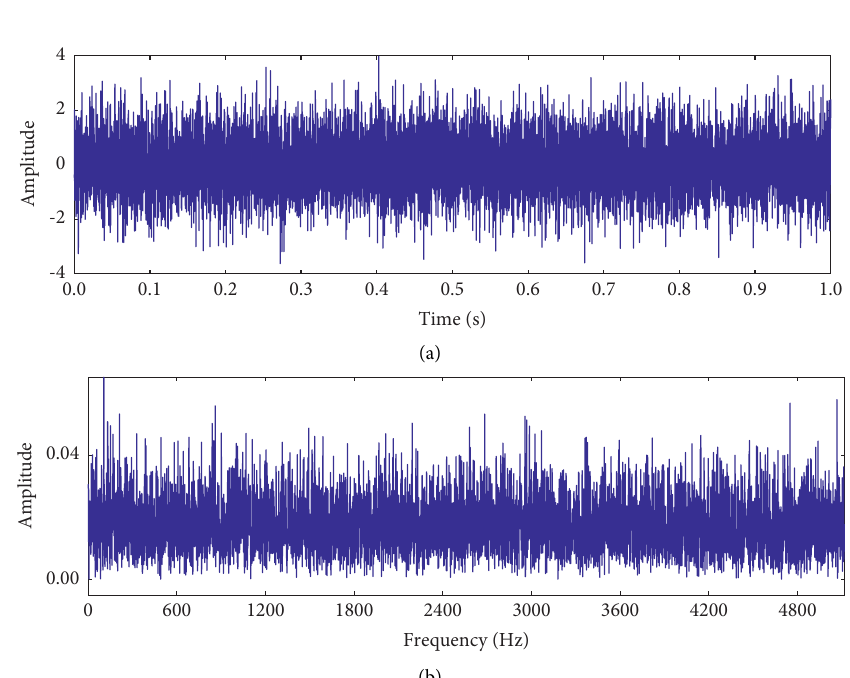
Figure 2: (a) Time domain waveform of white noise. (b) Frequency domain waveform of white